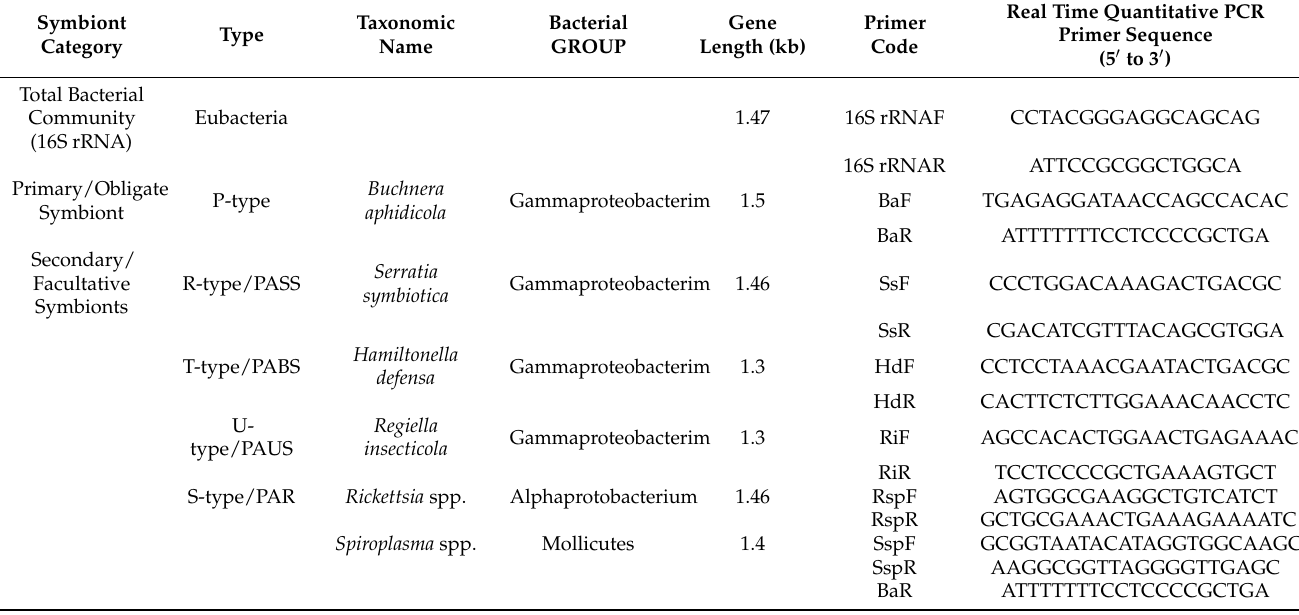
Table 1. Primer sequences used for the PCR amplification of total and aphid-specific bacterial symbionts of cereal